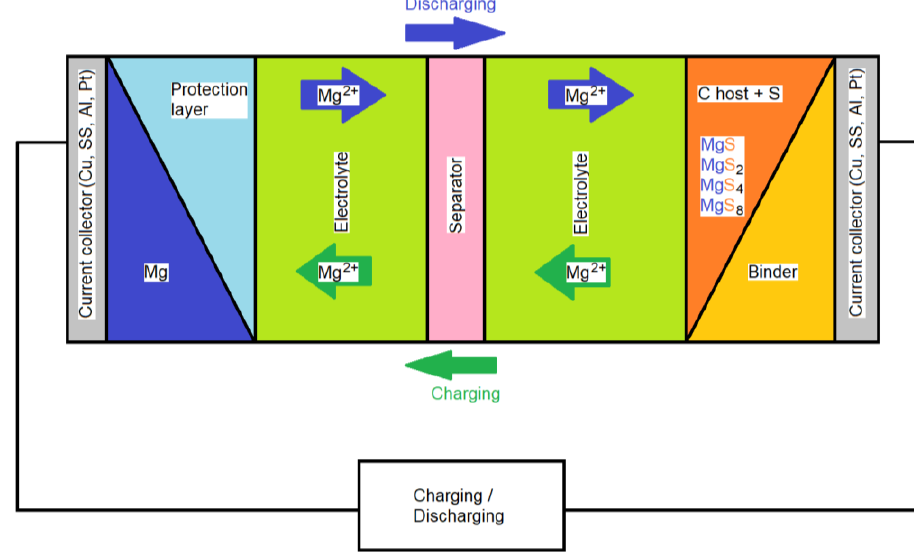
Figure 1. Scheme of an Mg–S cell. Based on [20].